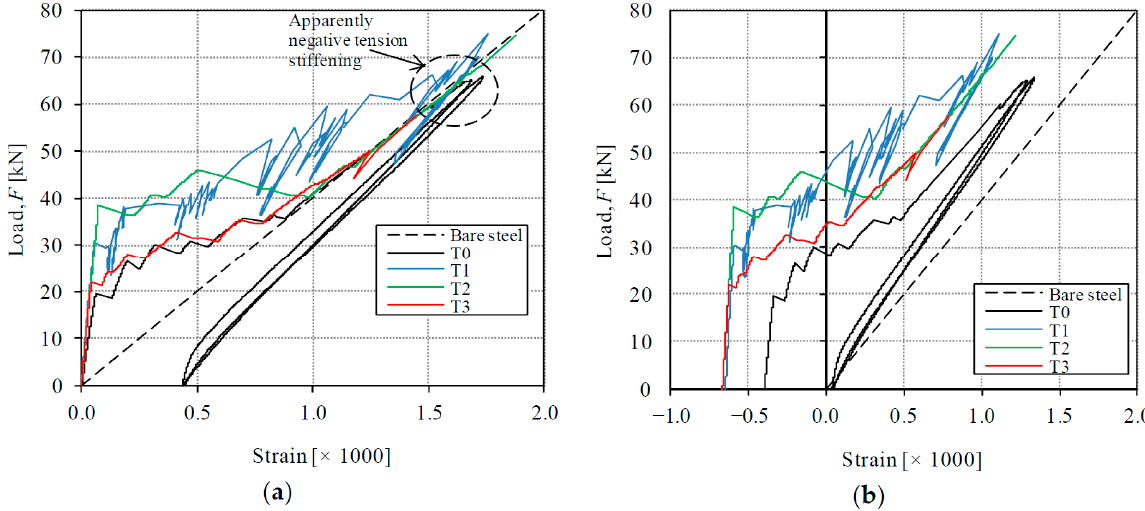
Figure 13. Effect of shrinkage on experimental behavior: ( a ) without shrinkage correction; ( b ) with shrinkage correction.